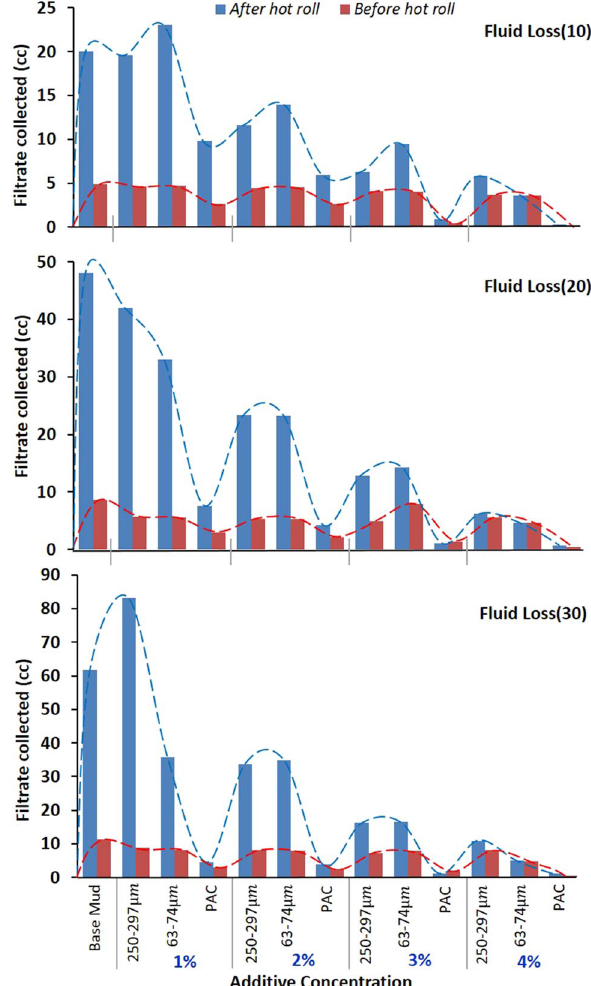
Fig. 15 Comparative analysis for YP, Gel0, Gel10 at varying con- centrations before and after hot roll is shown. The YP values of PAC showing that the before hot roll values are incredibly high and show- ing variations from the after hot roll values for a similar concentra- tion. Similarly, the Gel0 and Gel10 readings are also showing large variations between the before and after hot roll readings at all the concentrations. It is also noticed that the Gel10 readings of PAC at 3–4% concentration are showing abnormal behavior